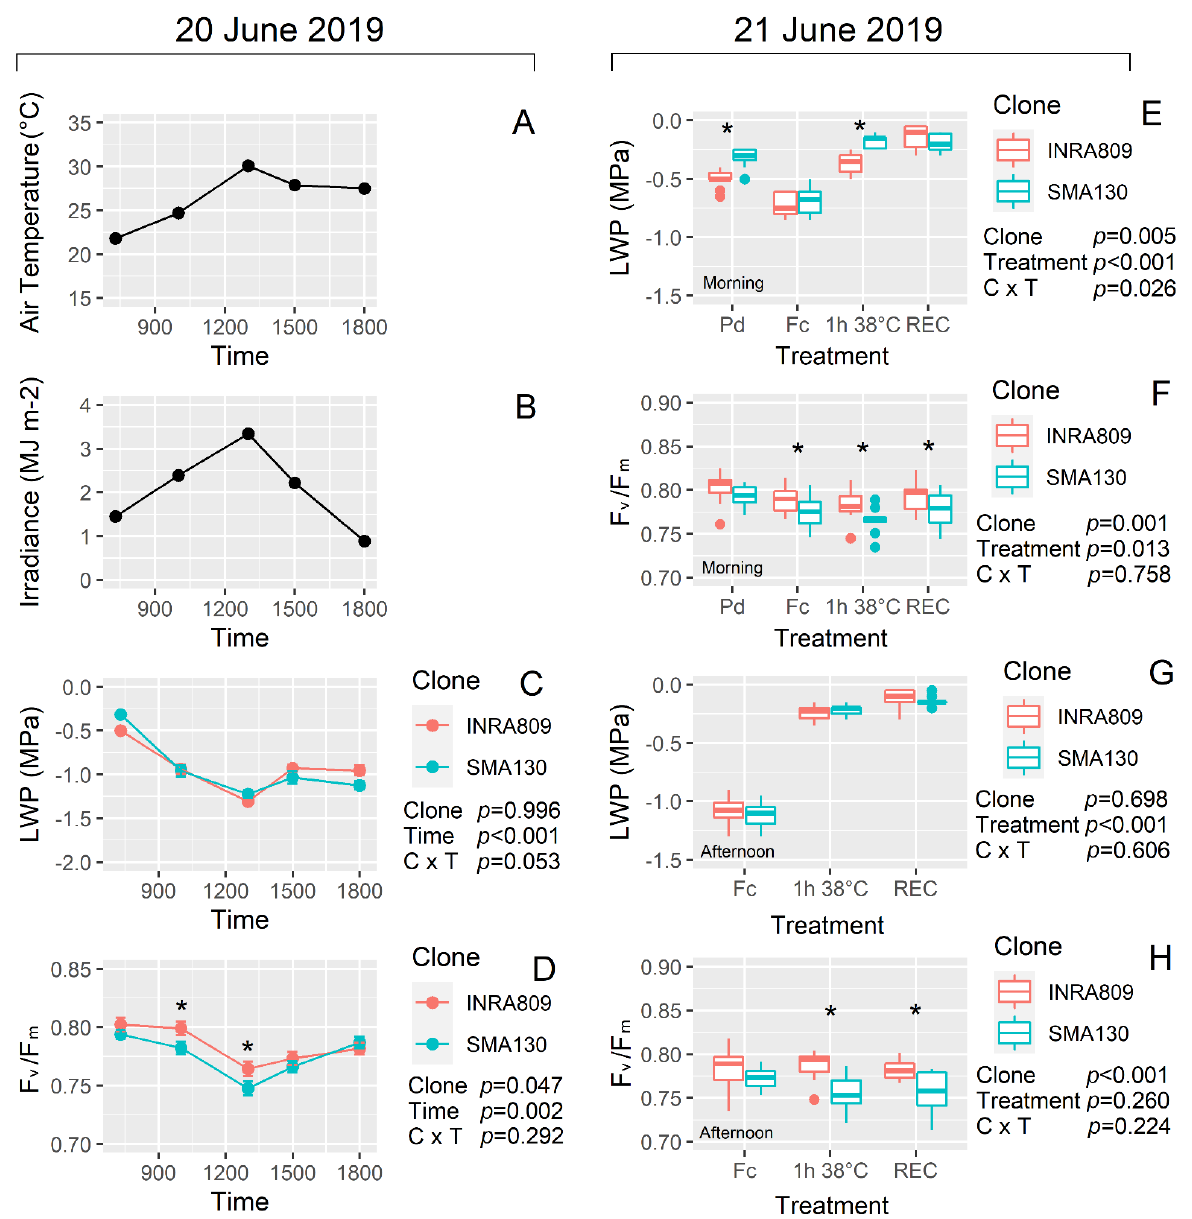
Figure 3. Diurnal changes in air temperature, irradiance, leaf water potential (LWP) and maximum quantum yield of photosystem II in dark-adapted samples (F v /F m ) collected on 20 June 2019 ( A – D ) and for INRA809 and SMA130. ( E , F ) represent the LWP and F v /F m response at different temperature conditions imposed in controlled conditions and in leaves collected in the morning of 21 June 2019 (Pd, pre-dawn; Fc, field condition; 1 h 38 ◦ C, conditions imposed in the growth cabinet; REC, recovery in the growth cabinet at 24 ◦ C). ( G , H ) represent the LWP and F v /F m response at different temperature conditions imposed in controlled conditions and in leaves collected in the afternoon of 21 June 2019 (Pd, pre-dawn; Fc, field condition; 1 h 38 ◦ C, conditions imposed in the growth cabinet; REC, recovery in the growth cabinet at 24 ◦ C). Data are means ( n = 9 – 10) ± standard error of the means (SEM). Data were collected in 2019 and subjected to a two-way ANOVA. ANOVA output is shown in the figure and for each trait. Asterisks show significant differences between clones according to t -test.